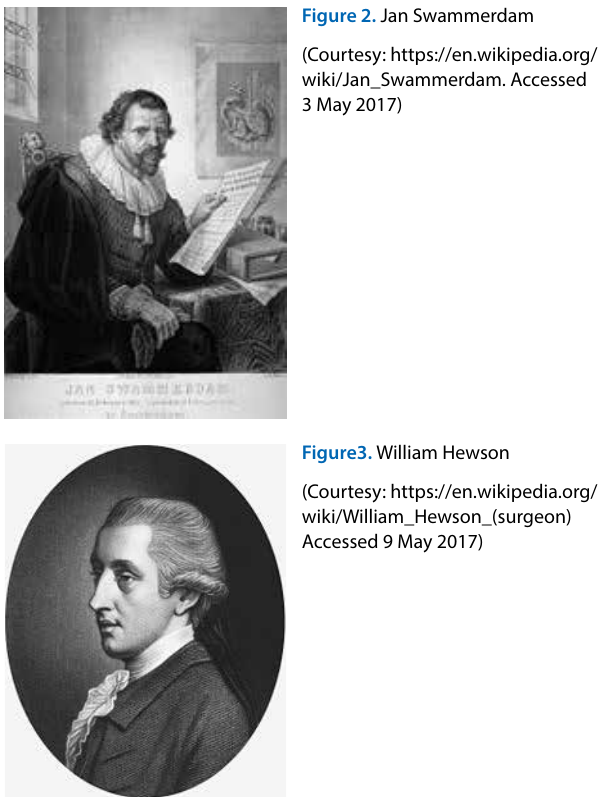
Figure 2. Jan Swammerdam